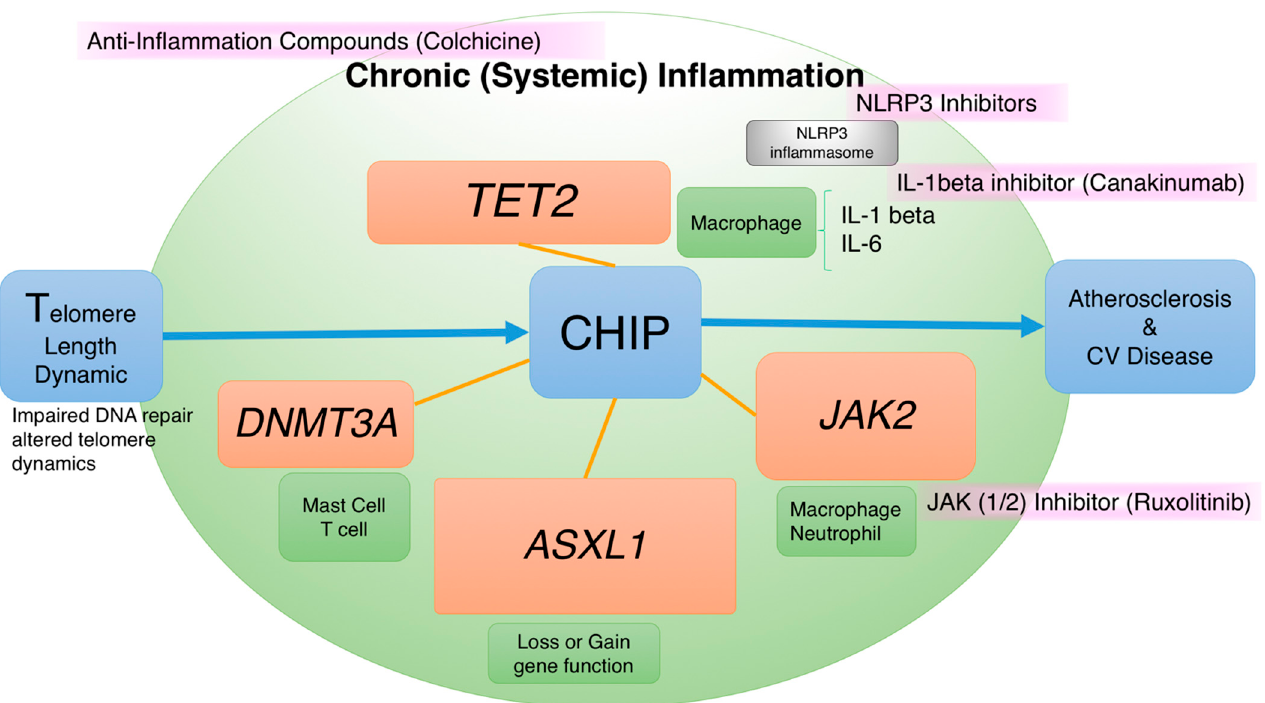
Figure 2. Telomere–CHIP–atherosclerosis (TCA) axis, somatic mutations, and potential therapeutic options. Four major mutant genes identified in patients with CHIP, namely TET2 , ASXL1 , JAK2 , and DNMT3A . Here, we highlight the possible therapeutic compounds targeting each CHIP-related mutant gene pathway. The general anti-inflammatory agents are colchicine, TET2-related NOD-, LRR-, and pyrin domain-containing protein 3 (NLRP3) inhibitors targeting NLRP3 inflammasome, IL-1 β inhibitor (canakinumab), and JAK2-related JAK(1/2) inhibitor (ruxolitinib).